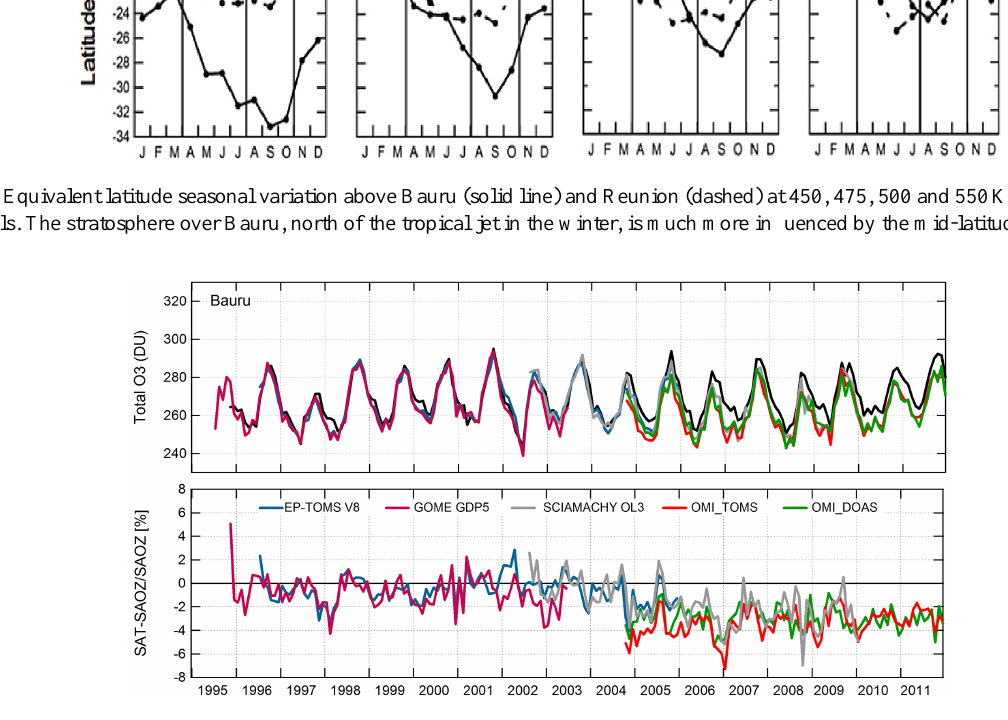
Figure 3. Total ozone over Bauru. Top: monthly mean column GOME GDP5 (pink), EP-TOMS (blue), SCIAMACHY OL3 (grey), OMI- TOMS (red), OMI-DOAS (green) and SAOZ sunrise–sunset average (black); Bottom: differences with SAOZ.